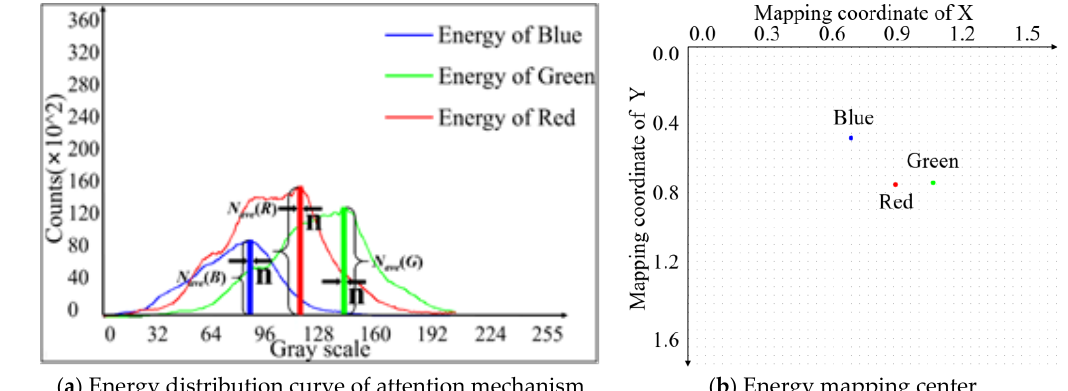
Figure 6. Data mapping.